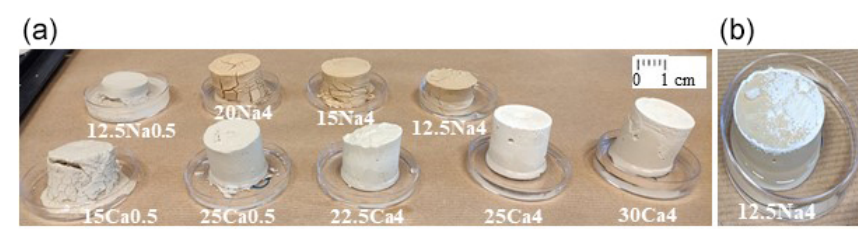
Figure 1. (a) Results from the second reactivity test, (b) detail picture of the efflorescence on the surface of 12.5Na4.